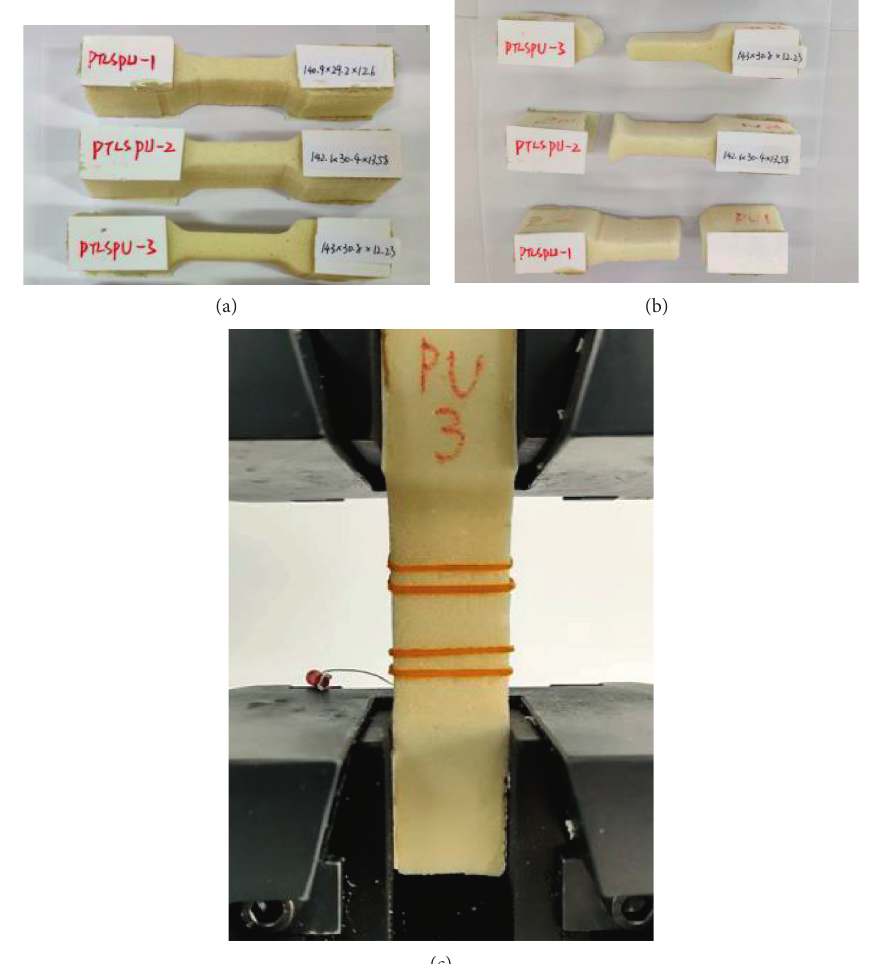
Figure 4: Experiments of polyurethane foam for uniaxial tension: (a) specimens before testing; (b) specimens after testing; (c) experimental